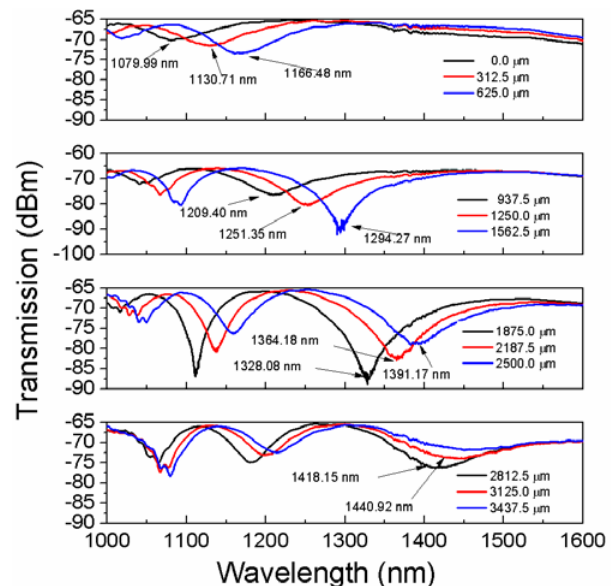
Figure 4. Spectral evolution of the transmission spectrum from the zero position (3.89 mm loop radius) to a displacement of 3,437.5 μ